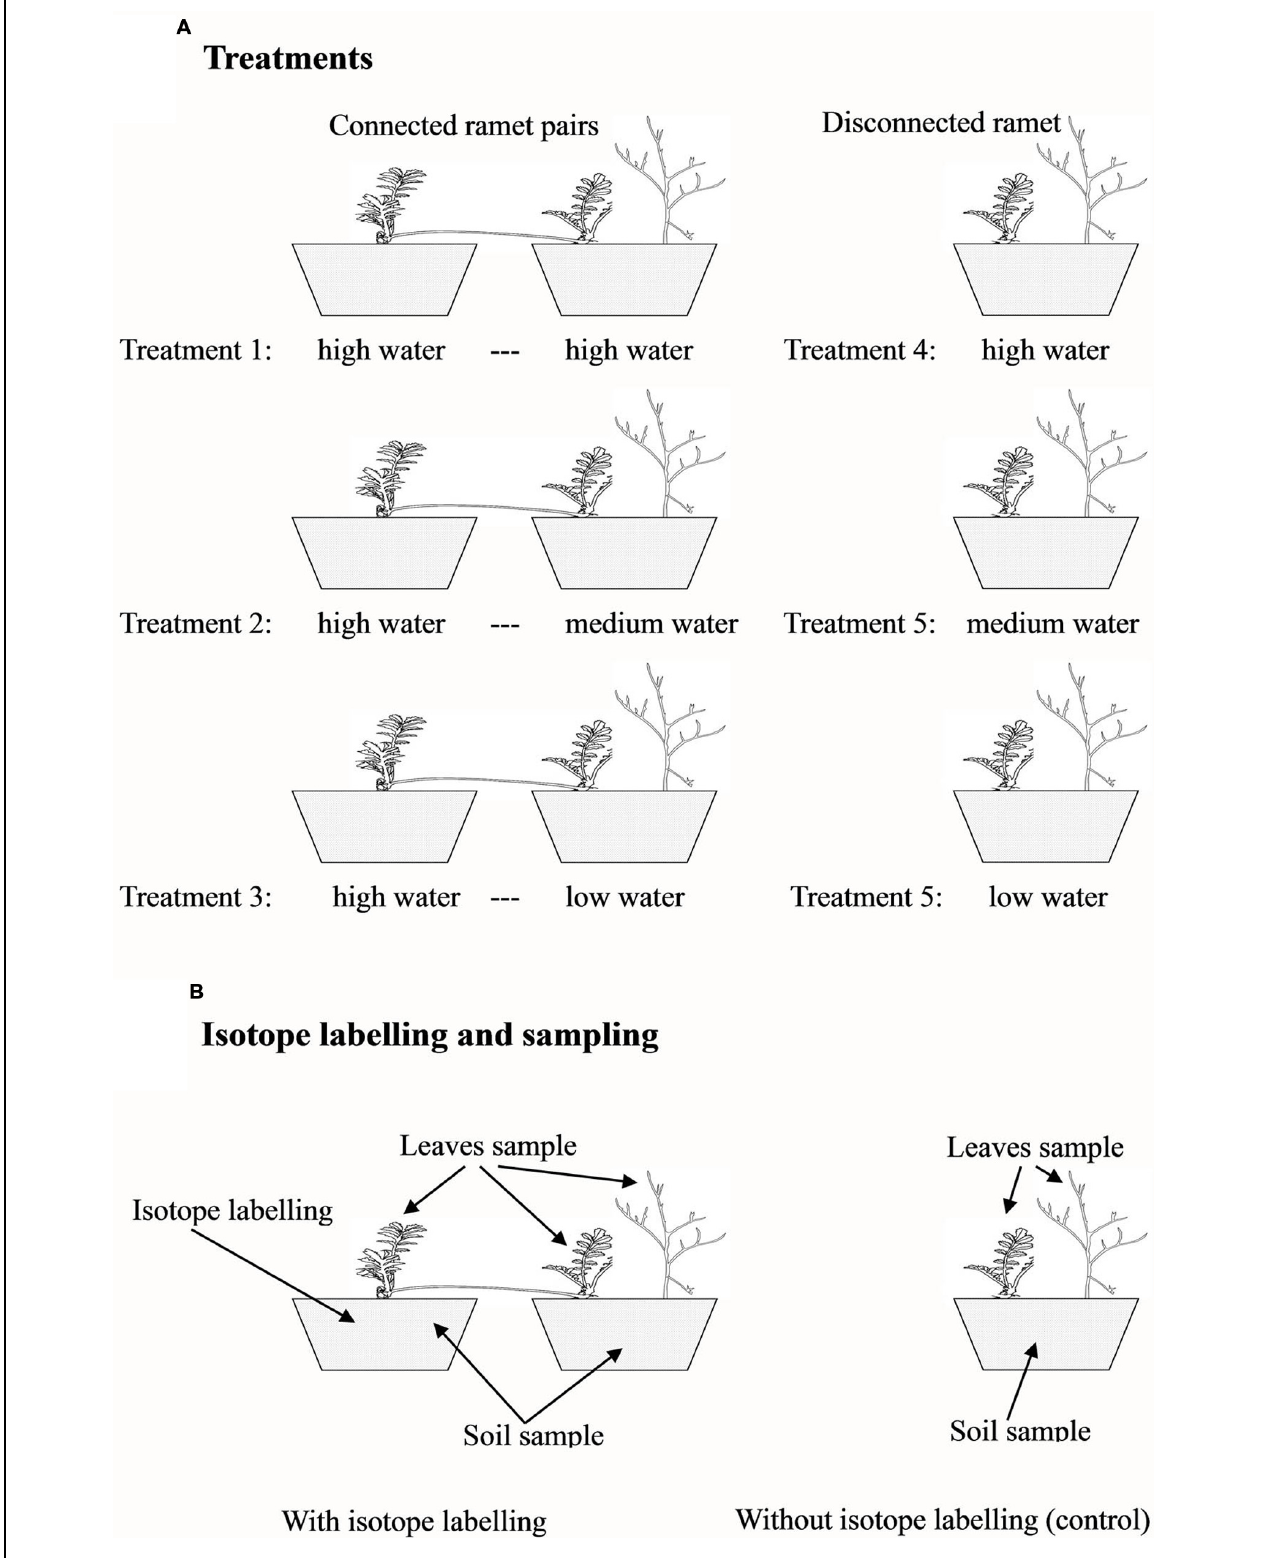
FIGURE 1 | Experimental design. Three water treatments for connected ramet pairs or for disconnected, single ramets (A) ; and the sampling design with or without isotope labeling (B) .